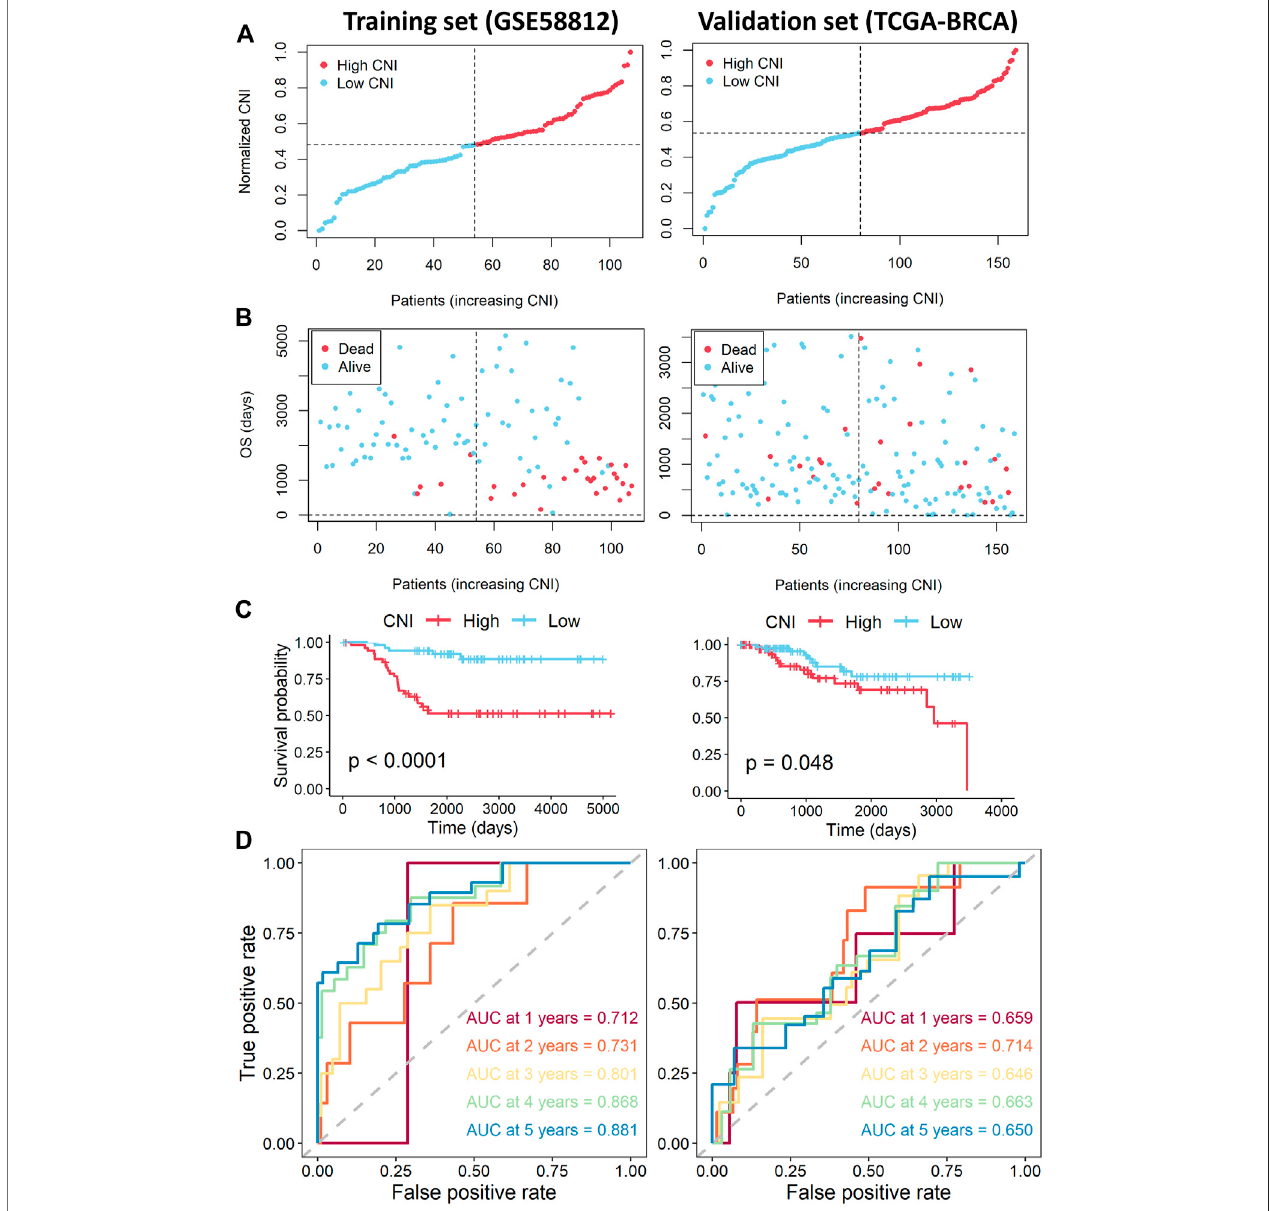
FIGURE 4 | Assessment of the necroptosis-related lncRNAs signature in the training and validation sets. (A) Distribution of CNI values in the training (left) and validation sets (right). (B) CNI value and survival status distributions of the training (left) and validation cohorts (right). (C) Kaplan – Meier curves for the overall survival of TNBC patients with high- and low-CNI in the training (left) and validation cohorts (right). (D) Time-independent ROC curves with AUC values to assess the prognostic accuracy of CNI value in the training (left) and validation (right)